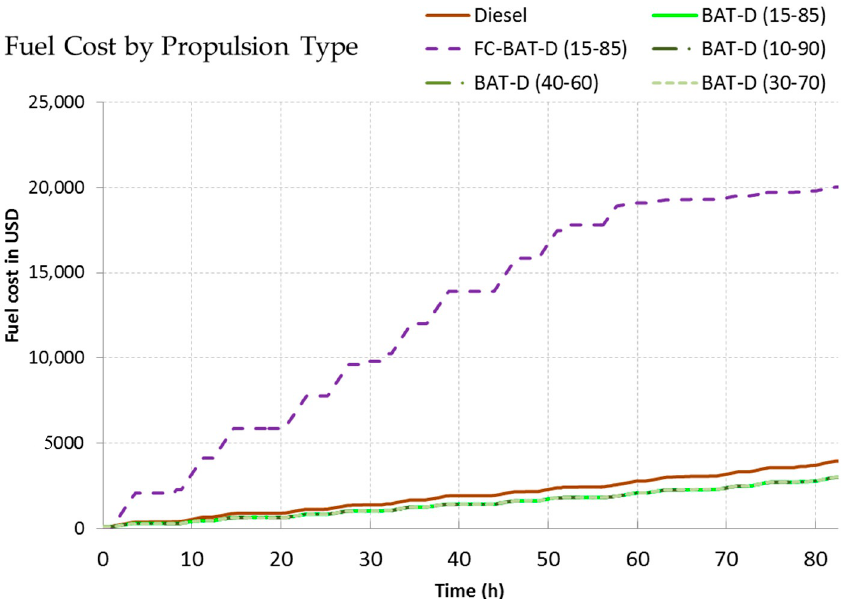
Figure 25. Comparison of operating costs of a SWATH II vessel on a given test route, depending on the adopted configuration of the drive system: DIESEL, BAT-D (15–85), BAT-D (10–90), BAT-D (30–70), BAT-D (40–60), FC-BAT-D (15–85).